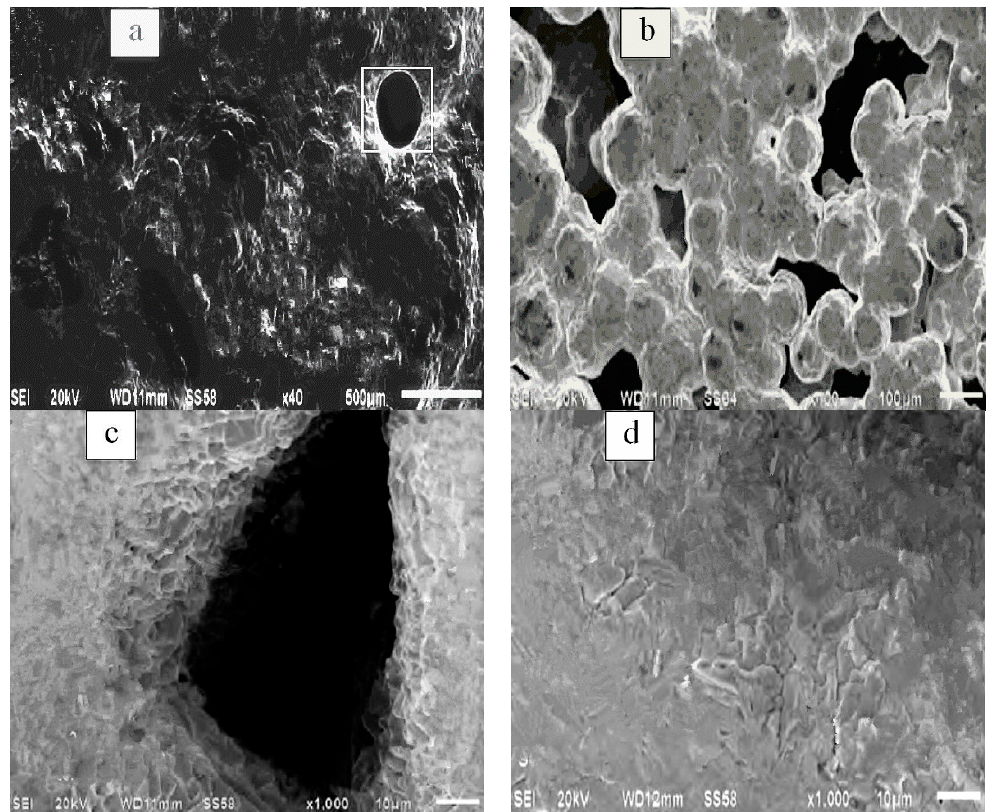
Figure 9. Surface microtopography of Au sediments. ( a ) 40-fold topography, ( b ) edge of sample, ( c ) hole, and ( d ) cracks.